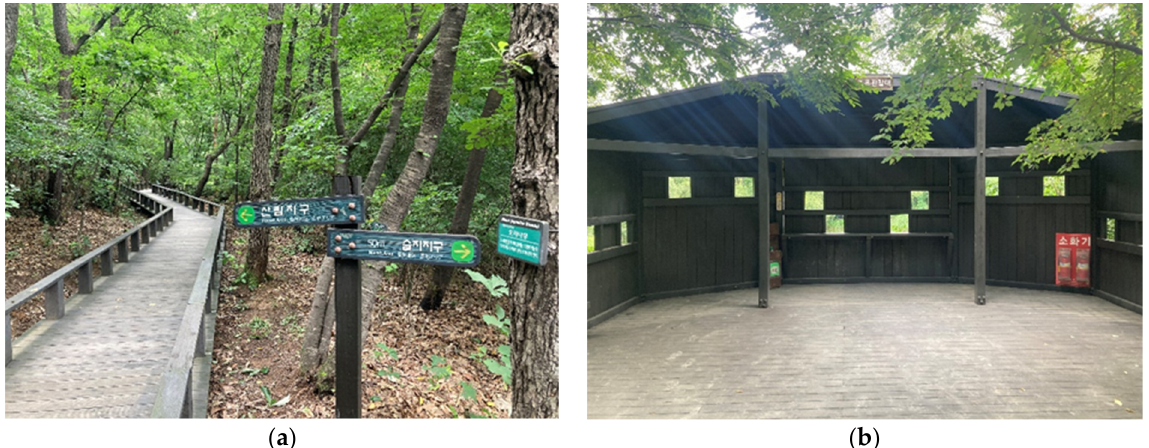
Figure 3. Gildong ecological park: ( a ) walking deck with a repetitive form; ( b ) limited observation point for birdwatching. Source: Author’s photographs.